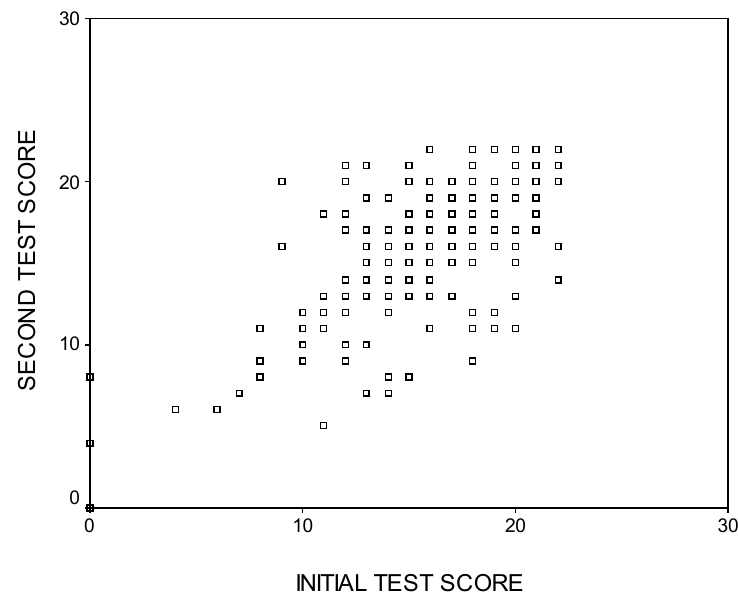
Figure 1. Scatter plot of the HK-LS test-retest